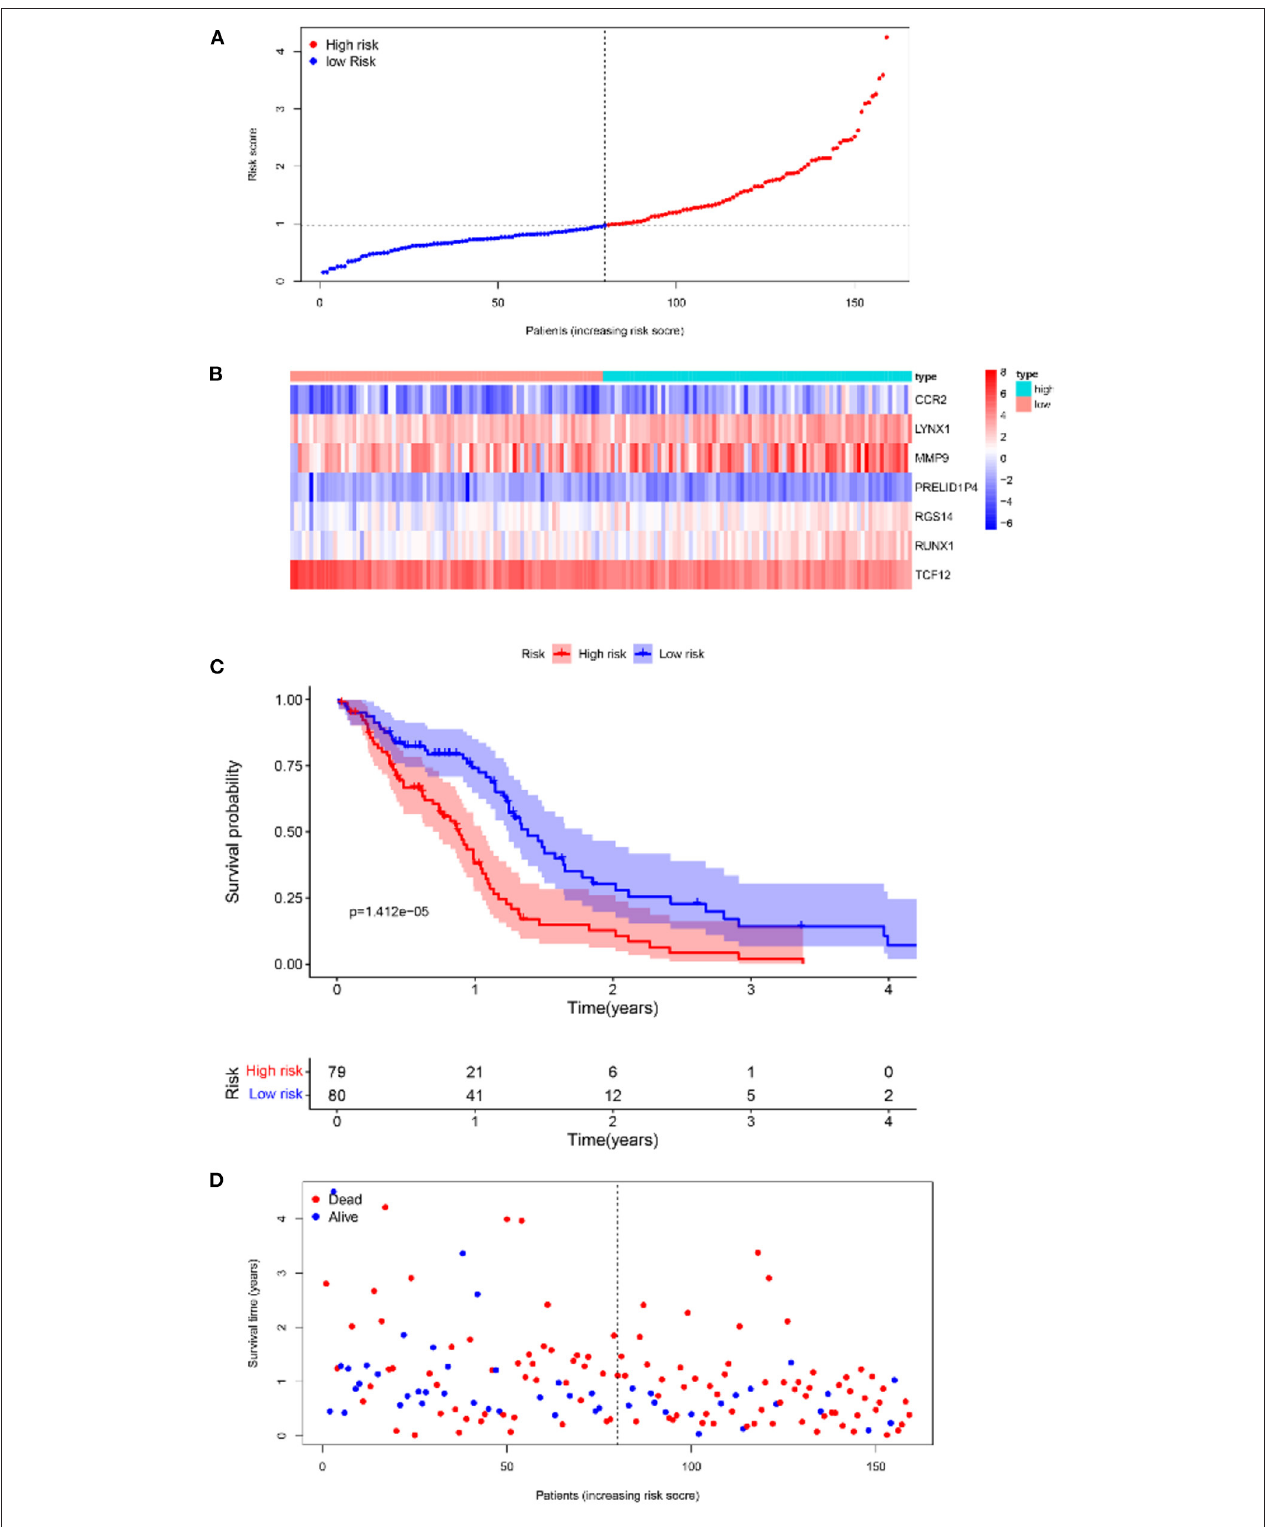
FIGURE 6 | Survival analyses of the prognostic model in the TCGA-GBM cohort. (A) Risk score scatter map. (B) Heat map of differential expression of 7 marker genes. (C) The KM curves of OS in the high- and low-risk groups. (D) Survival status scatter map.